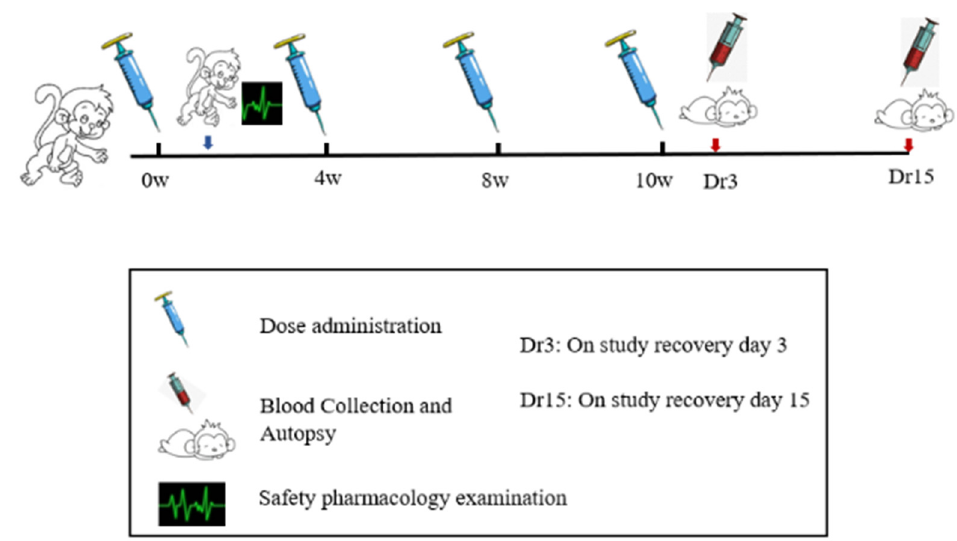
Figure 2. The study flowchart for safety evaluation of the ZF2001 vaccine.